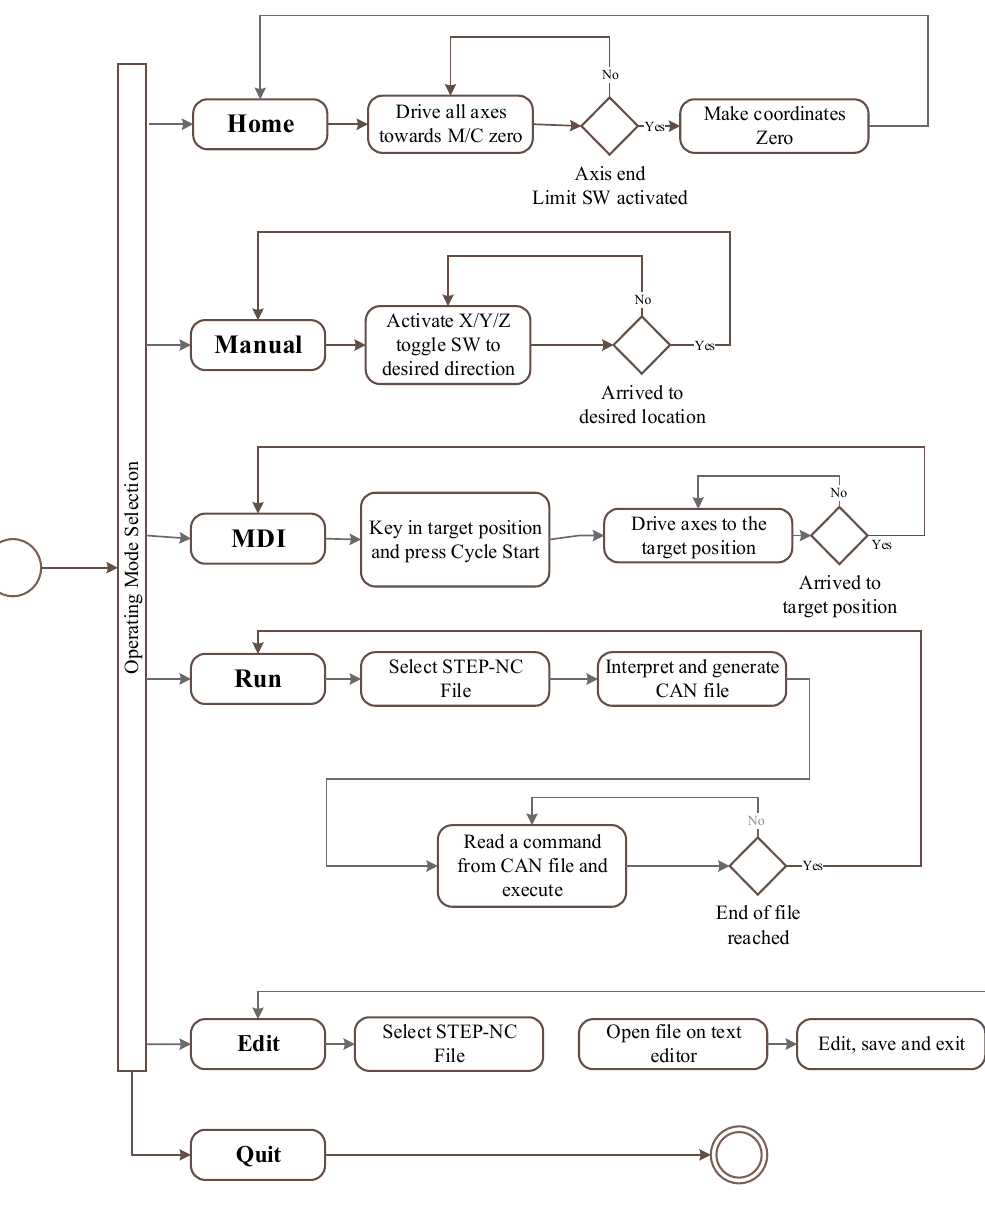
Figure 6. Functions of operation modes.